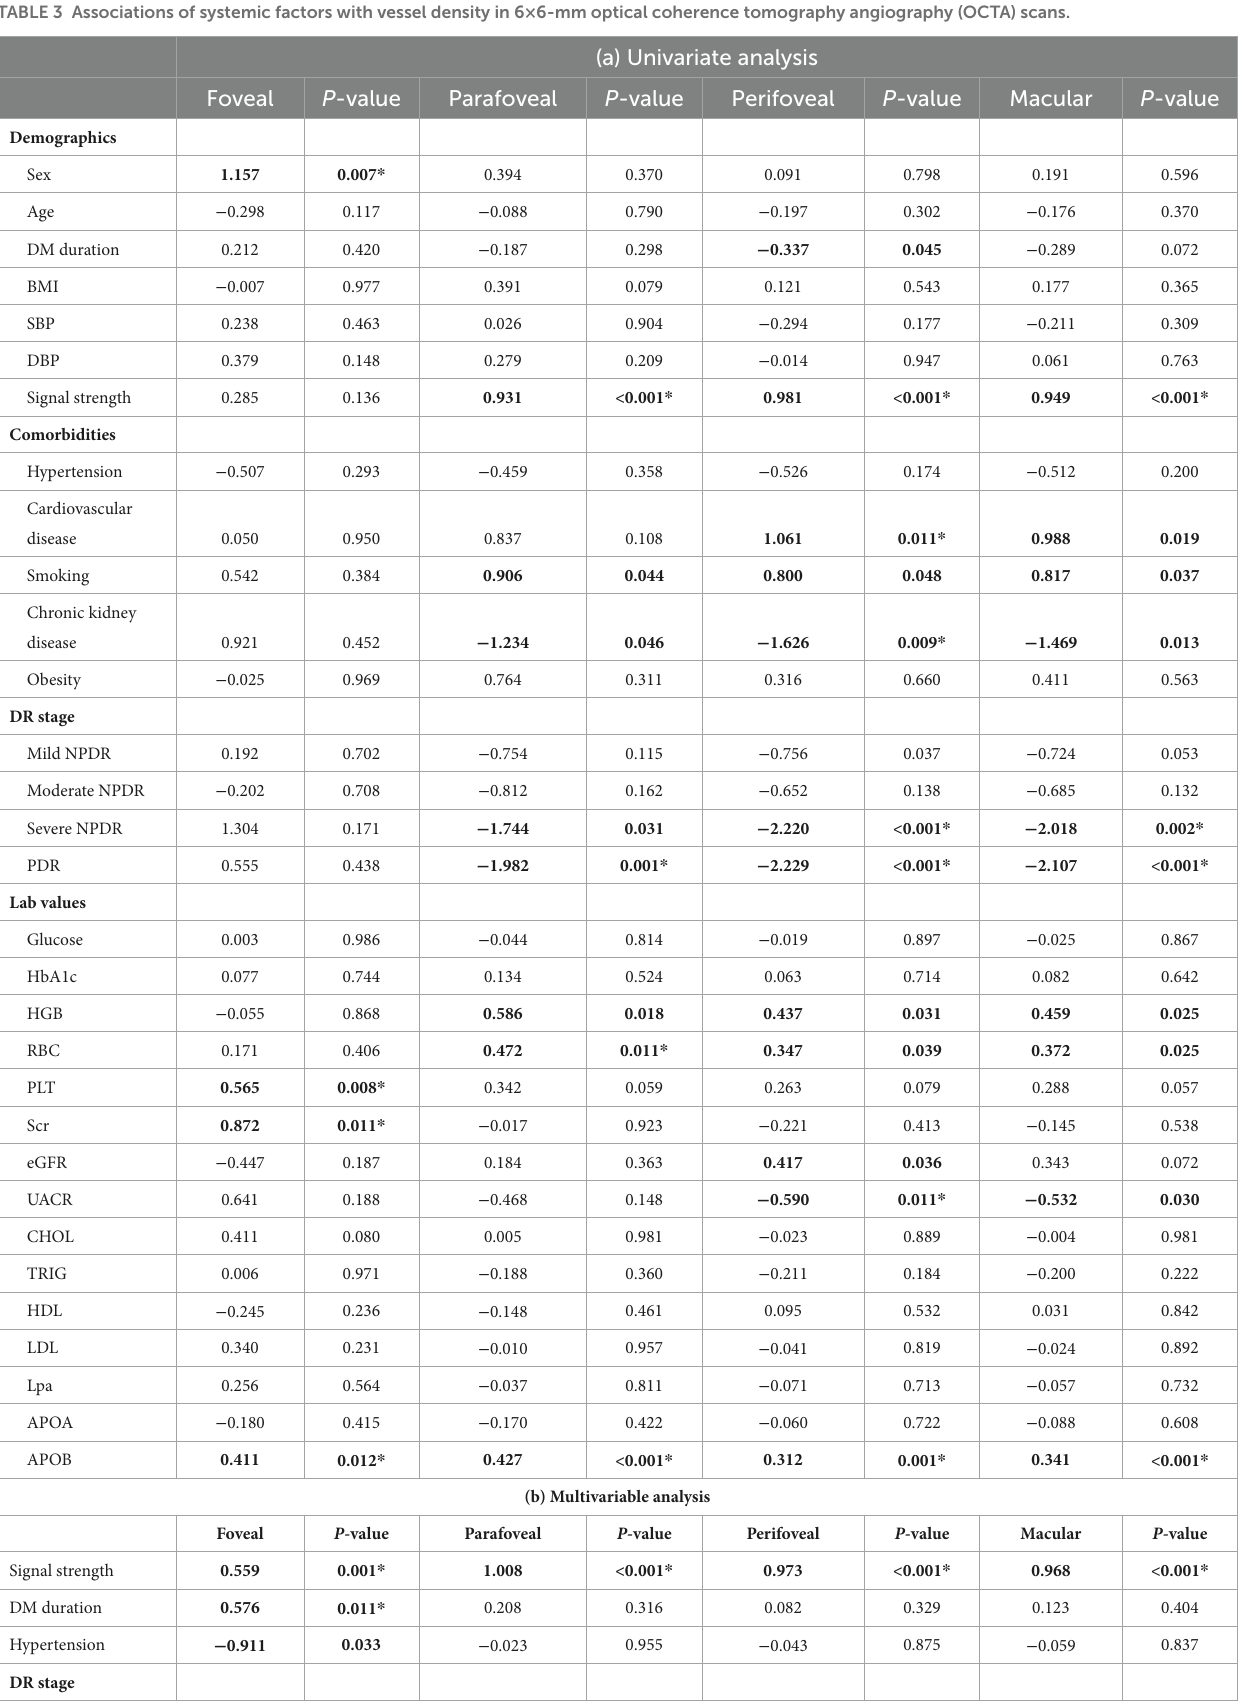
(a) Univariate analysis